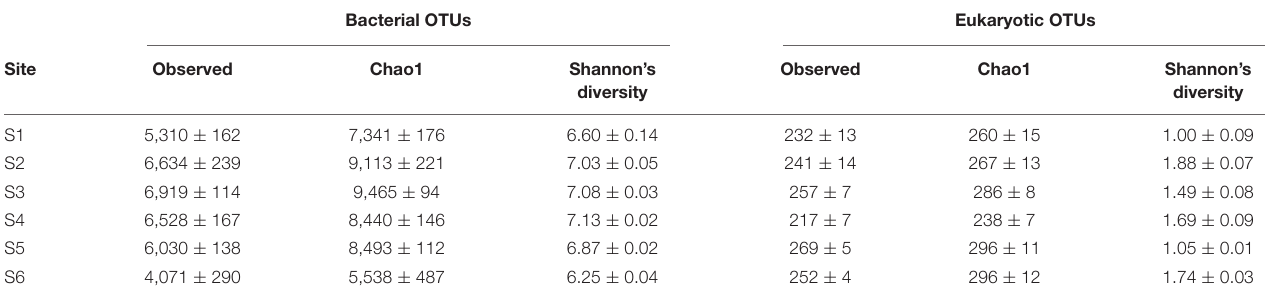
TABLE 5 | Observed bacterial and eukaryotic OTU frequencies and diversity indices (Chao1 and Shannon’s diversity) for sediment samples collected from six sampling stations in Haverö, Archipelago Sea (Baltic Sea, Finland).